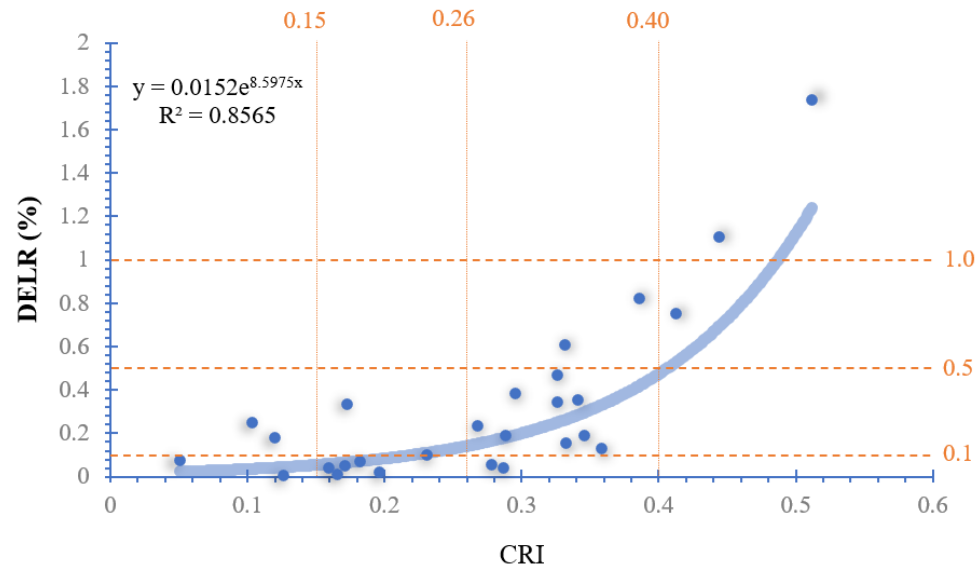
Figure 3. Correlation between CRIs and DELRs. Table 3. CRIs and DELRs of flash floods in Weifang.